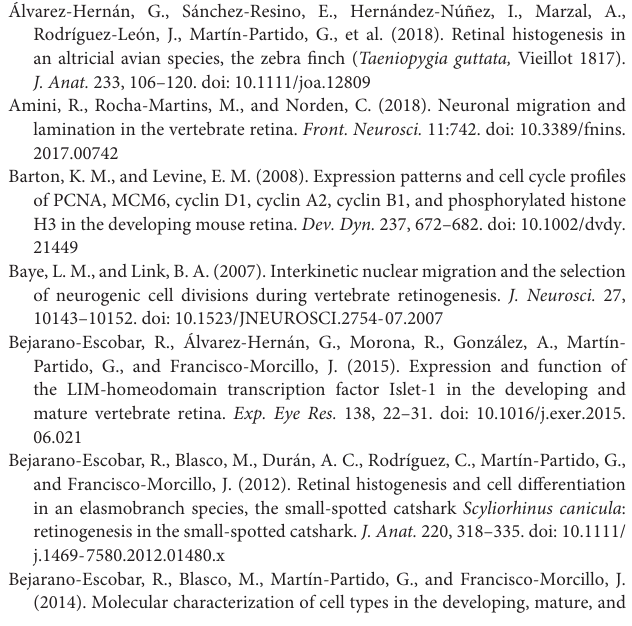
Supplementary Figure 1 | Toluidine blue-stained semi-thin section (A) and expression of cell markers in cryosections (B–H) of the embryonic retina of C. coturnix . Cryosections were counterstained with DAPI. (A,A (cid:48) ) Mitotic figures were found in the apical surface (arrows) and in non-apical regions [arrowheads in panels (A,A (cid:48) ) ]. (B) Apical (arrows) and non-apical (arrowhead) pHisH3-immunoreactive mitoses were found in the NbL at St34. (C) Prox1-immunoreactive presumptive horizontal cells (arrows) were found in the horizontal cell layer at St35. Prox1 immunoreactivity was also found in the nuclei of migrating precursors of horizontal cells in more internal regions of the NbL (arrowheads). (D) Prox1-immunolabelled horizontal cells (arrows) were mainly located in the laminated retina at St42. Prox1-immunostained horizontal cell precursors were found in more internal regions (arrowheads). A subpopulation of amacrine cells was immunopositive against Prox1 antibody (double arrowheads). (E) At St35, Isl1 immunosignal was detected in presumptive horizontal cells (arrows) and migratory neuroblasts (arrowheads) in the undifferentiated retina. (F) At St35 Is1 immunoreactivity was found in the nuclei of subpopulations of ganglion, amacrine, bipolar and horizontal cells. (G,H) Prox1 immunoreactivity was found in horizontal cells at St 42 (arrowheads) and a sub-population of Prox1 immunoreactive horizontal cells was co-labeled for Isl1 (double arrowheads). Abbreviations: GCL, ganglion cell layer; INL, inner nuclear layer; IPL, inner plexiform layer; NbL, Neuroblastic layer; ONL, outer nuclear layer. Scale bars: 50 µ m in A-G; 5 µ m in panel (A (cid:48) ) ; 25 µ m in panel (H)